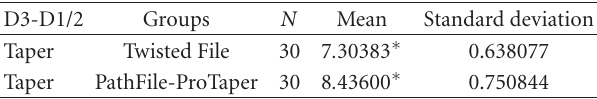
Table 1: Mean percent di ff erence and standard deviation from .08 nominal taper in the apical third among 2 systems.